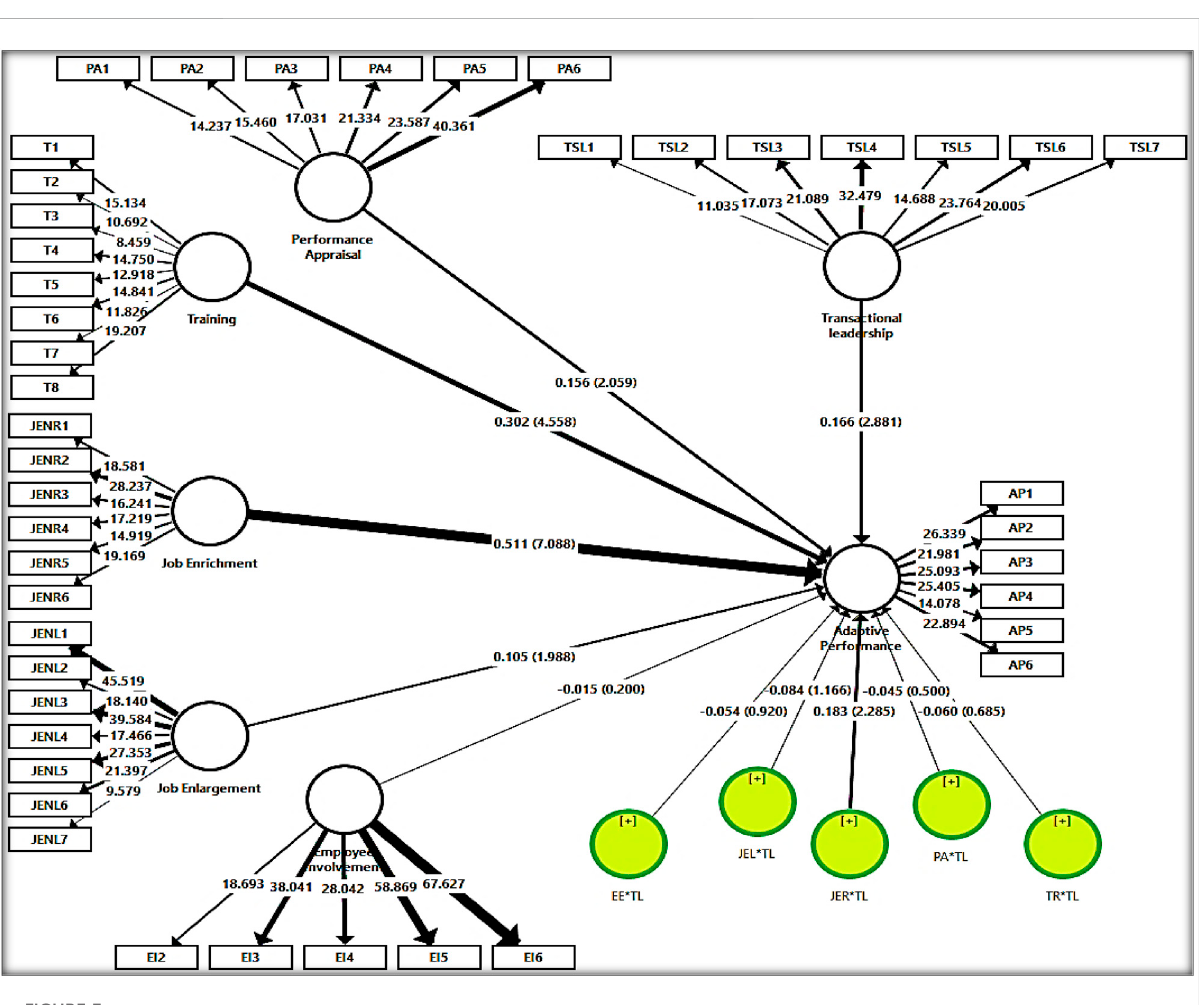
FIGURE 3 Structural model with the path coef fi cient and t -values from the bootstrapping test.